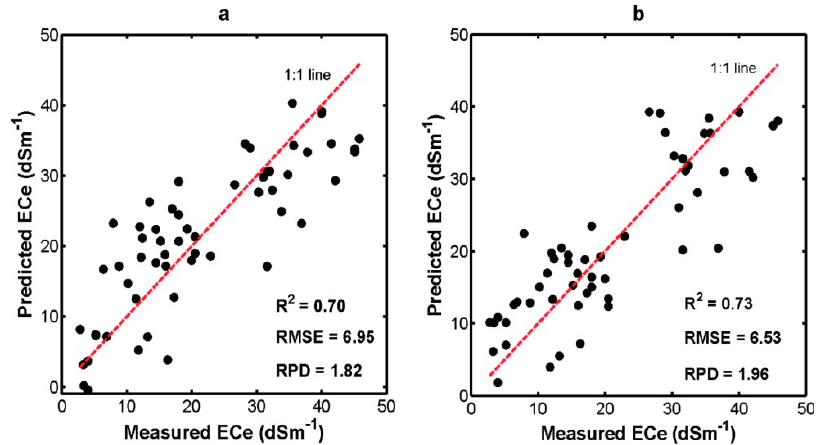
Figure 5. Evaluation of the PLSR model ( a ) and the MARS model ( b ) based on resampled laboratory spectra and the measured EC e .